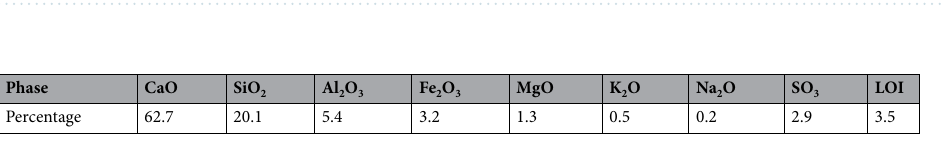
Table 1. Cement composite samples containing various amounts of BN–Fe 3 O 4 nanostructures.